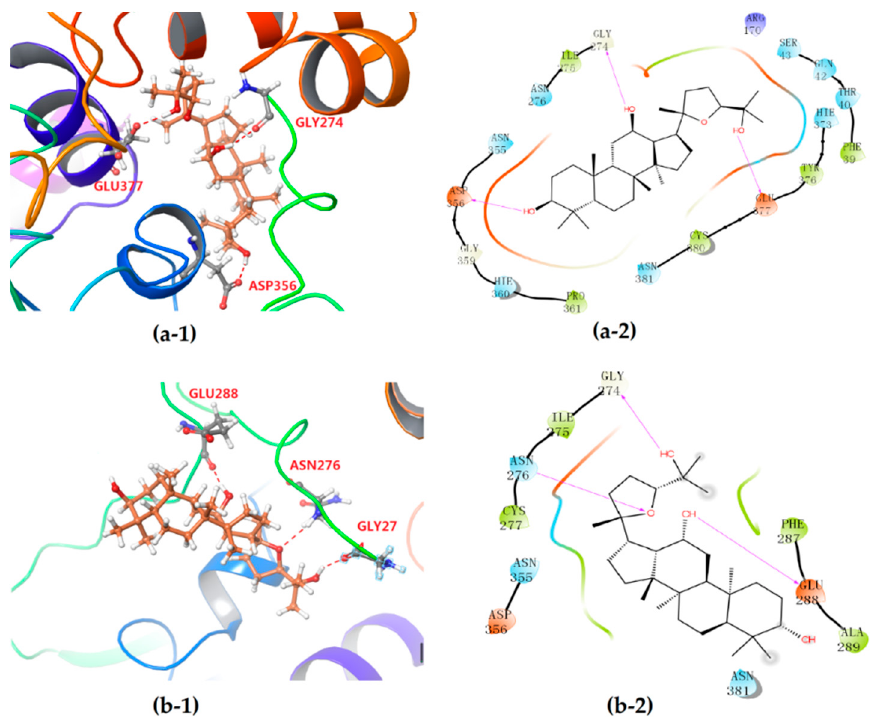
Figure 5. 3-D ( 1 ) and 2-D ( 2 ) diagrams illustrating the molecular interaction of 24 S -PDQ ( a ) and 24 R -epimer ( b ) with the modeled UGT1A8. ( 1 ) The ball-stick structure: PDQ; the cartoon stucture: UGT1A8. ( 2 ) Purple arrow: hydrogen bond; red: charged (negative); purple: charged (positive); white: glycine; green: hydrophobic; blue: polar.